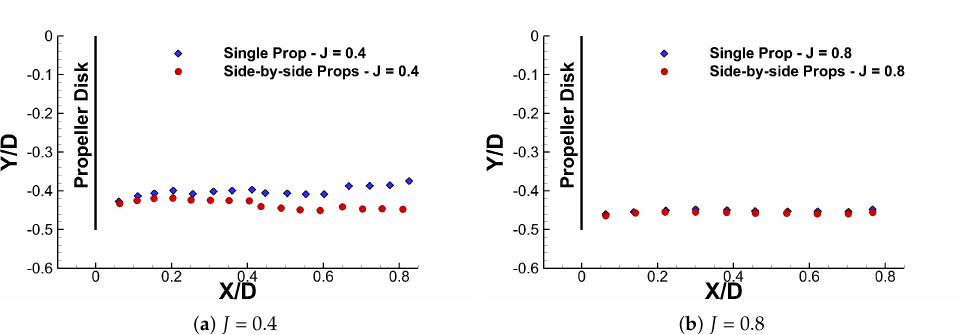
Figure 9. Comparison of the tip vortex core displacements at advance ratios J = 0.4 and J = 0.8 between a single propeller and an upper side-by-side propeller at L y / D = 0.05, Re D = 1.96 × 10 6 , and M t =